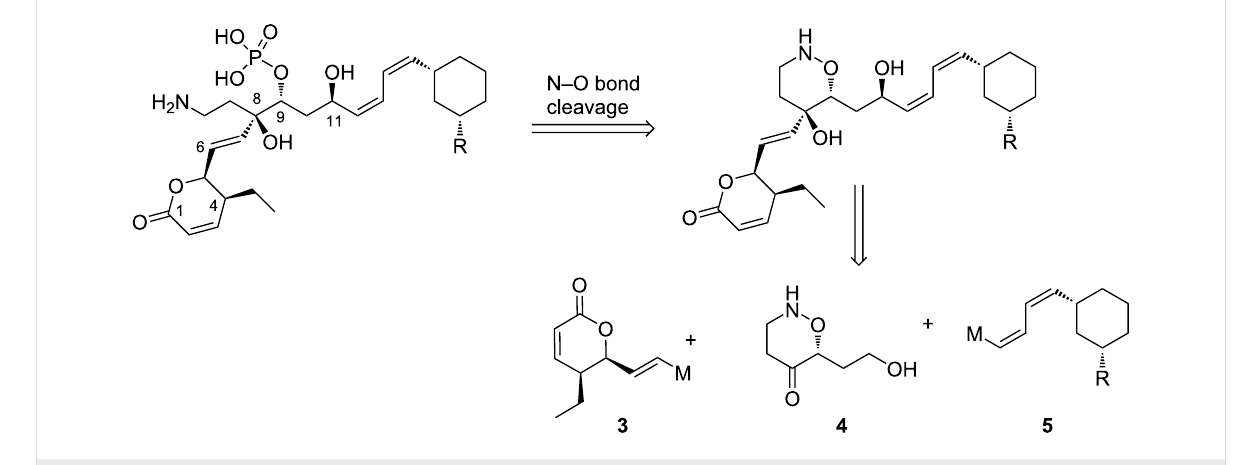
Figure 2: Synthetic strategy for the leustroducins and phoslactomycins.